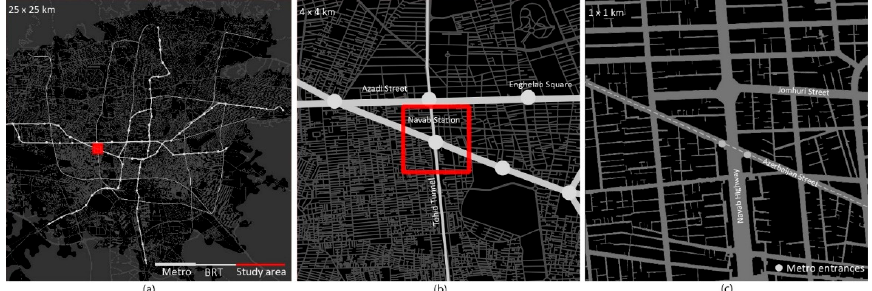
Figure 2. The West: Navab station area. 25 km × 25 km ( a ), 4 km × 4 km ( b ), and 1 km × 1 km ( c ). Maps: Nastaran Peimani. Maps: Nastaran